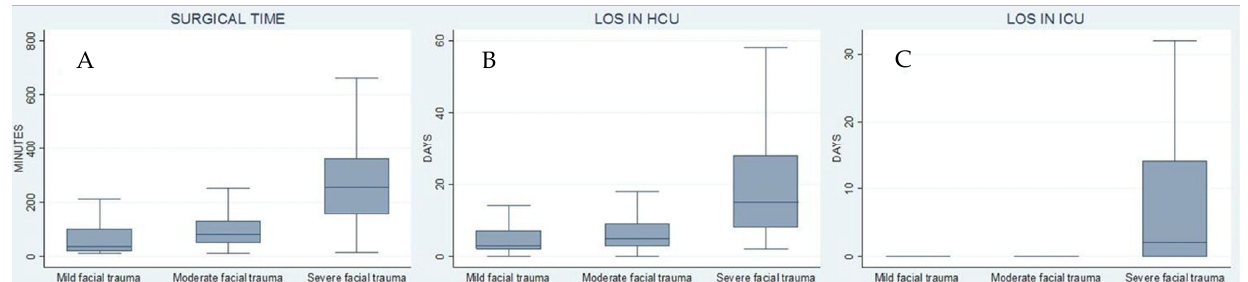
Figure 4. Bar chart highlighting the percentage of patients that will be treated with surgery and general anesthesia in mild, moderate, and severe stratified facial trauma patients. The box plots of overall surgical time, LOS in HCU, and LOS in ICU help visualize Table 4 results and the differences between mild/moderate and severe facial trauma patients (Figure 5).